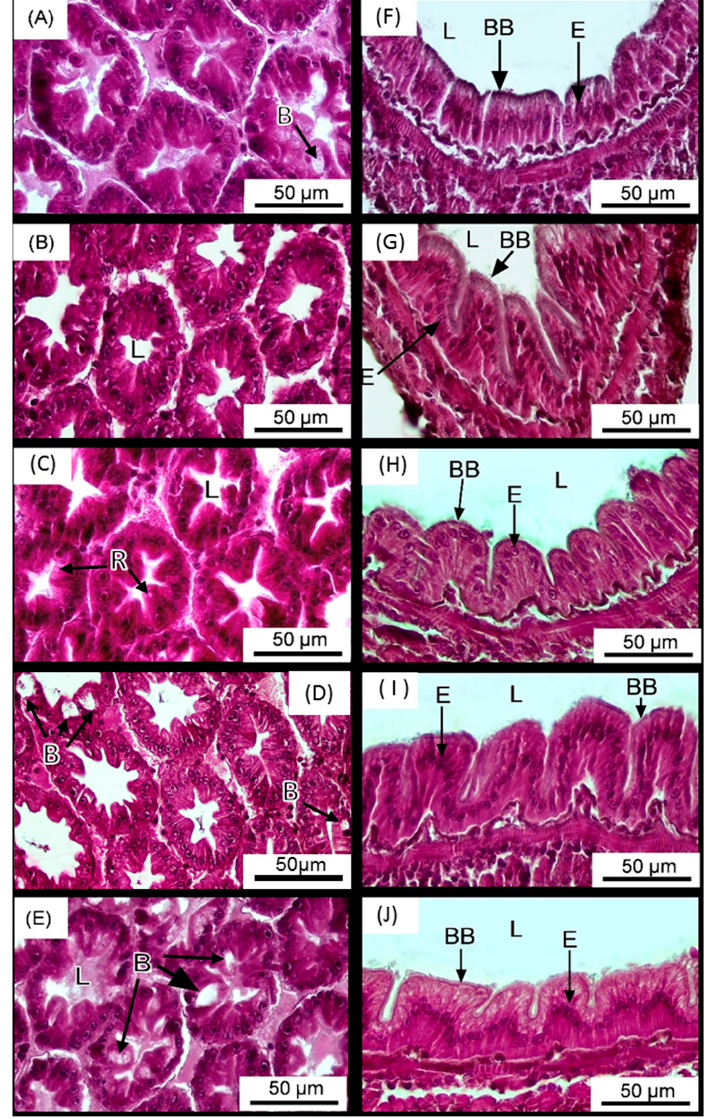
Figure 2. Histology sections (H&E staining) of the hepatopancreas ( A – E ) and intestines ( F – J ) of